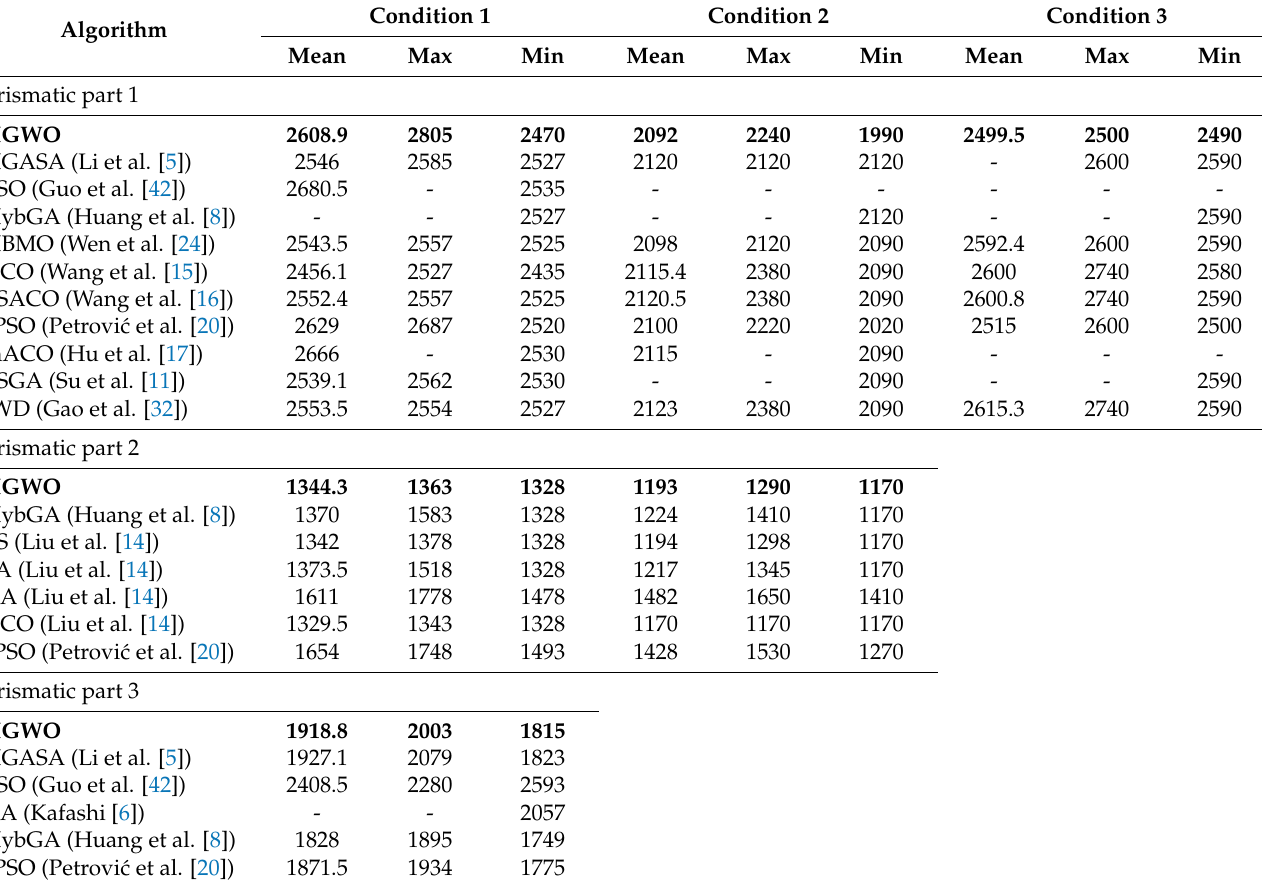
Table 9. Comparative results of HECSA with other algorithms for three prismatic